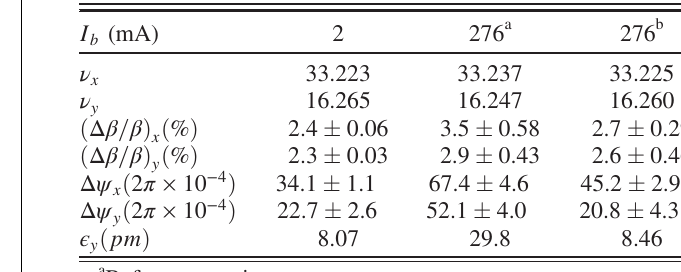
TABLE II. Comparison of measured lattice distortions at different beam